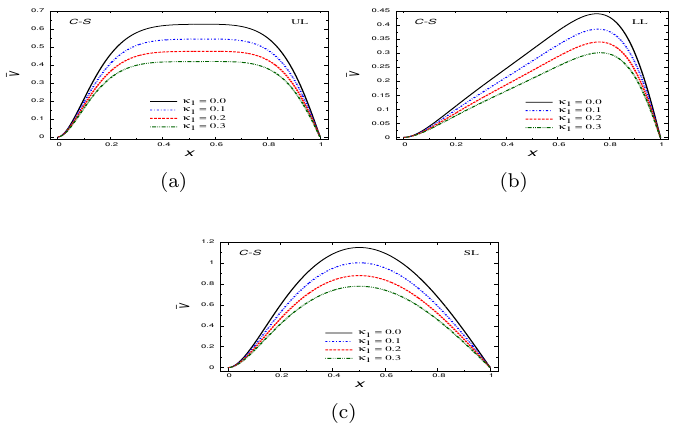
Figure 10. Effect of Winkler’s parameter κ 1 on of the distribution of angular displacement along the axial direction of a C-S CNT subjected to: (a) UL, (b) LL, and (c) SL.